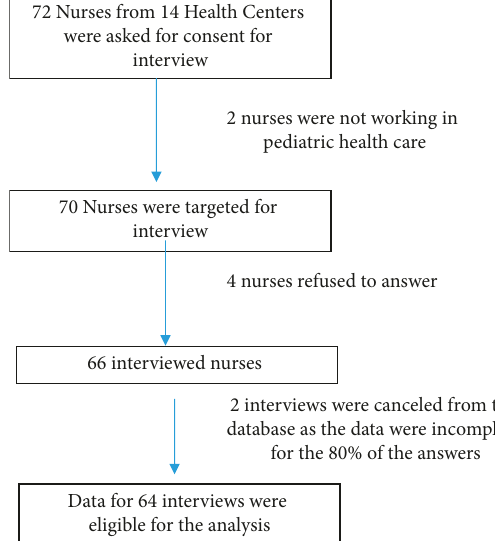
Figure 1: Flowchart of the health staff